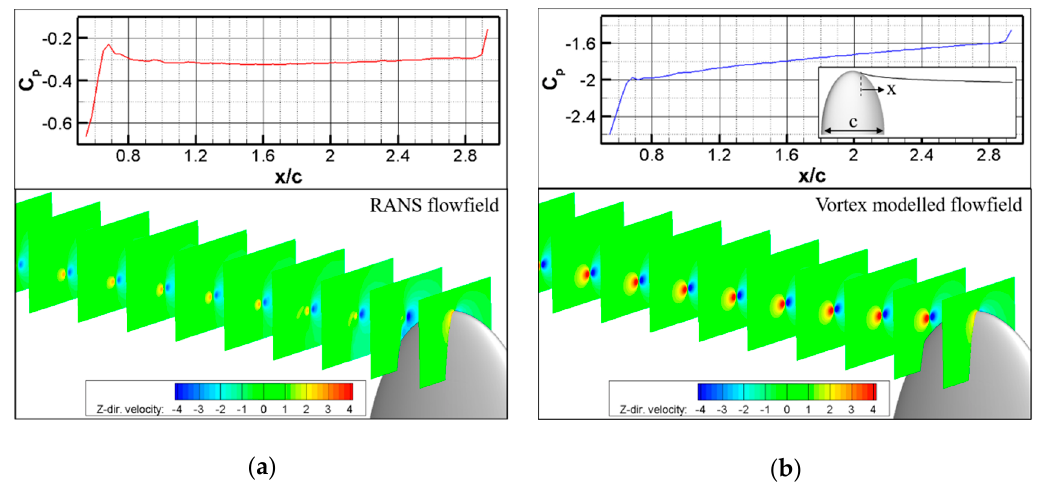
Figure 18. Comparison of pressure coefficient (top) and z-directional velocity (bottom) between ( a ) RANS and ( b ) vortex-modelled flow field.